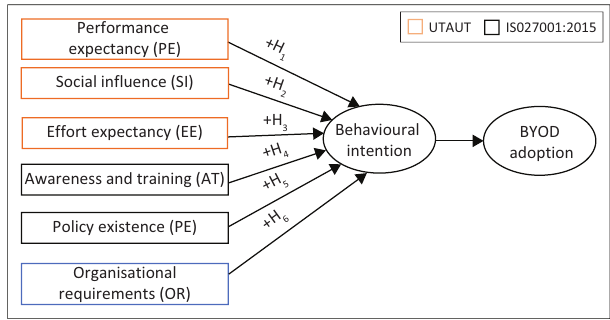
FIGURE 2: The proposed model – unified theory of acceptance and use of technology + International Organization for Standardisation/International Electrotechnical Commission